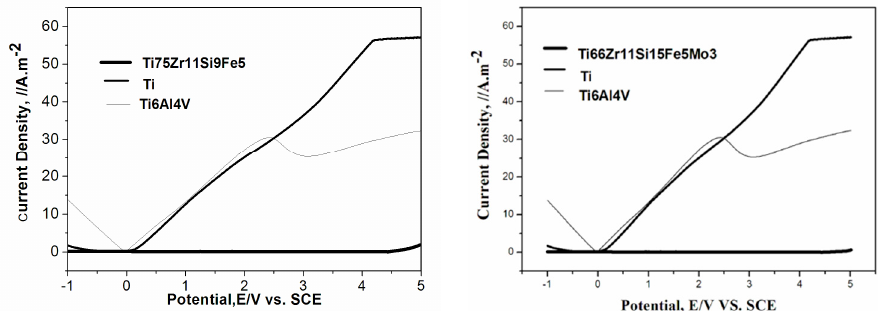
Figure 5. The potentiodynamic polarization curve of both Ti75Zr11Si9Fe5 (At %) and Ti66Zr11Si15Fe5Mo3 (At %) amorphous alloys in 3 mass% NaCl solution open to air at 298